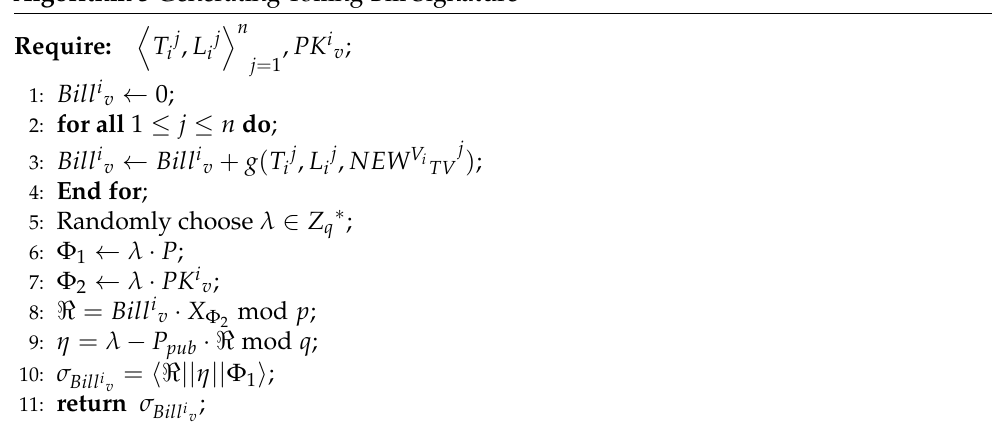
Algorithm 3 Generating Tolling Bill Signature